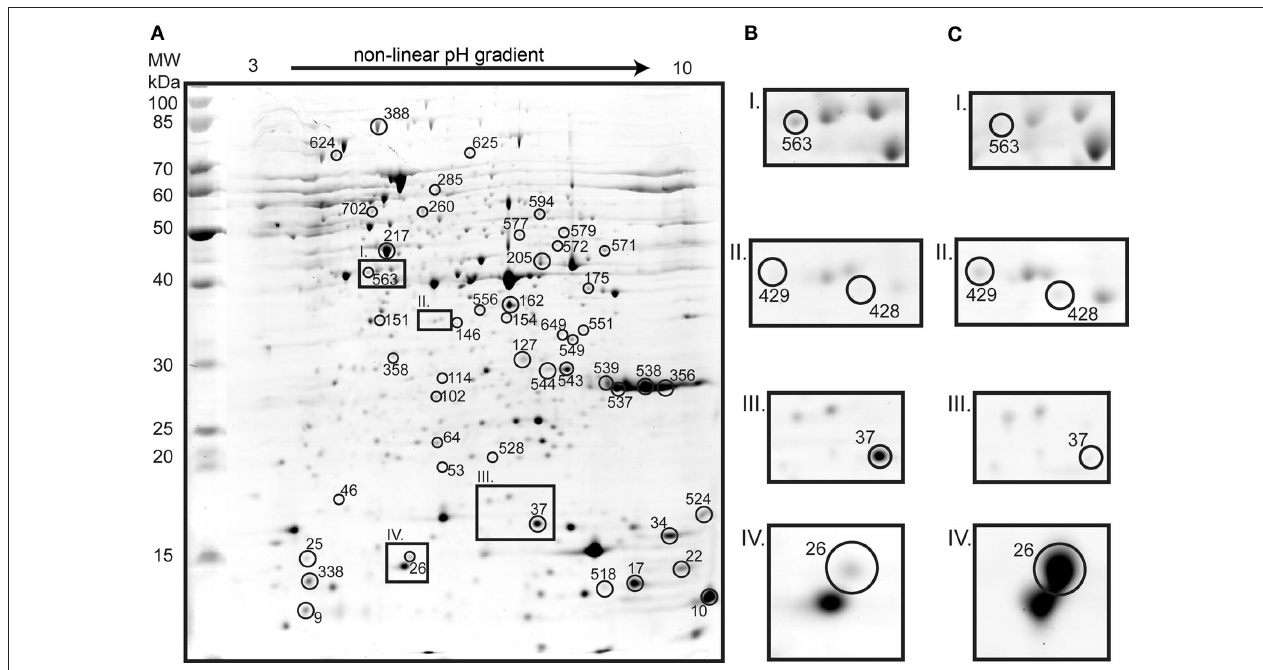
unique in tetrathionate grown cells (I); heat shock protein GroEL (S429 and S428) unique in S 0 grown cells (II); twin-arginine translocation protein TatA (S37) which was 3.8-fold up-regulated in tetrathionate (III); and heat shock protein Hsp20 (S26) that was 8.6-fold up-regulated in S 0 grown cells (IV).